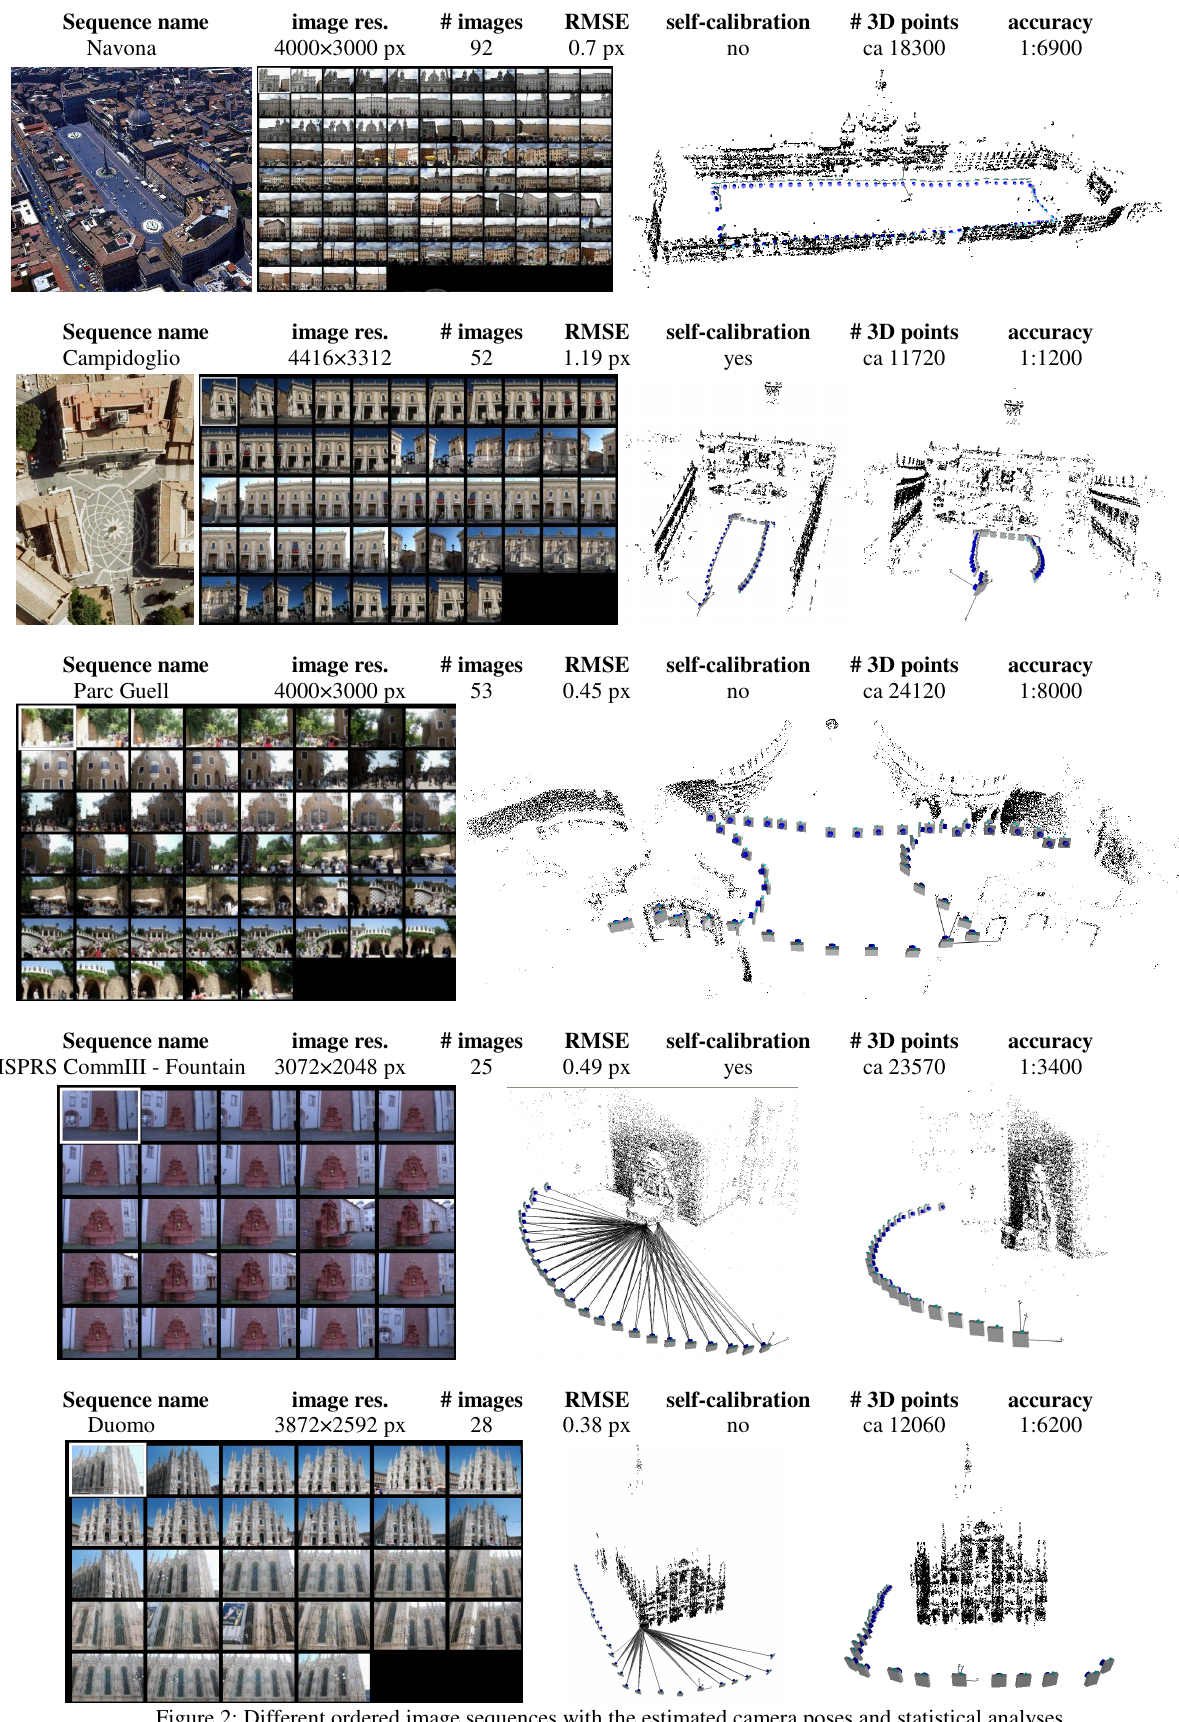
Figure 2: Different ordered image sequences with the estimated camera poses and statistical